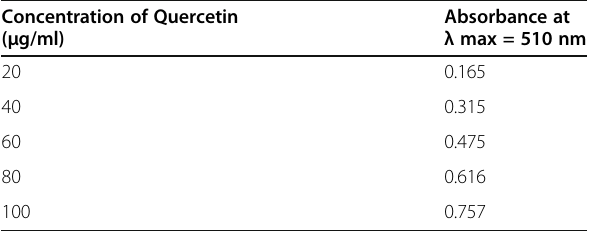
Table 2 Absorbance of Quercetin in chelated form at λ max = 510 nm